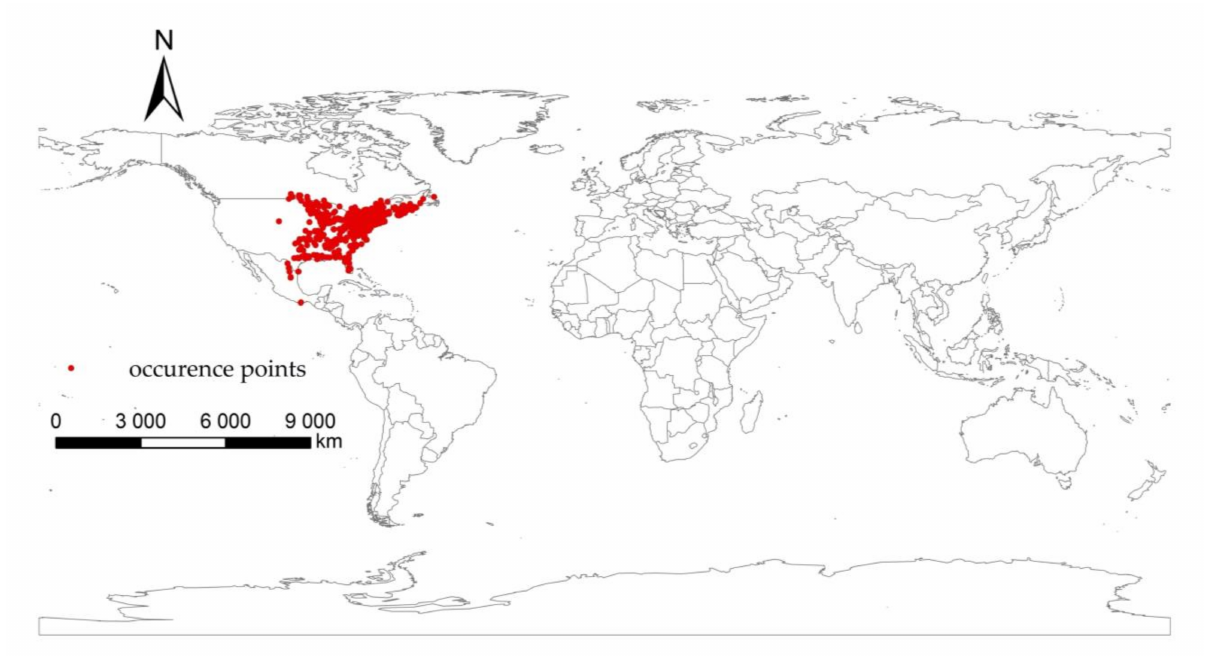
Figure 1. Current occurrence of Ixodes scapularis